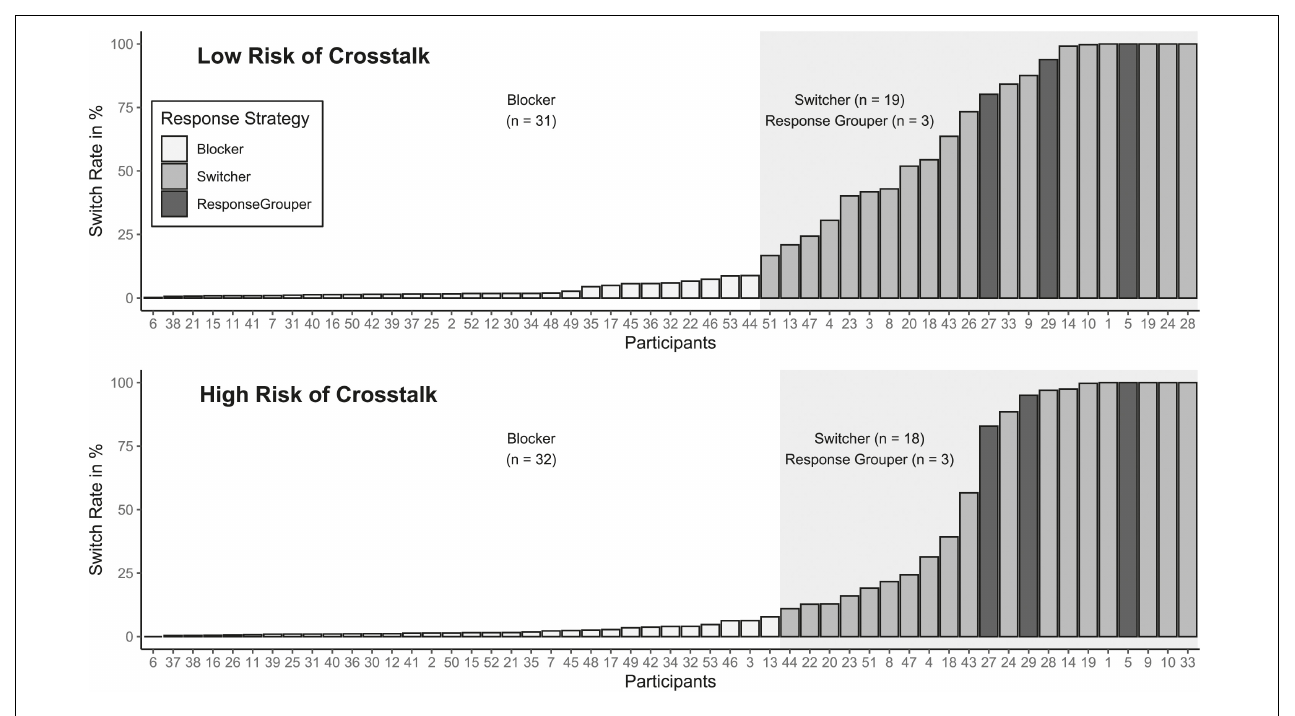
FIGURE 3 | Individual switch rates in percentage and identified strategies for both crosstalk conditions. Switch rates indicate the number of performed switches in relation to the total number of possible switches and are displayed in ranked order.